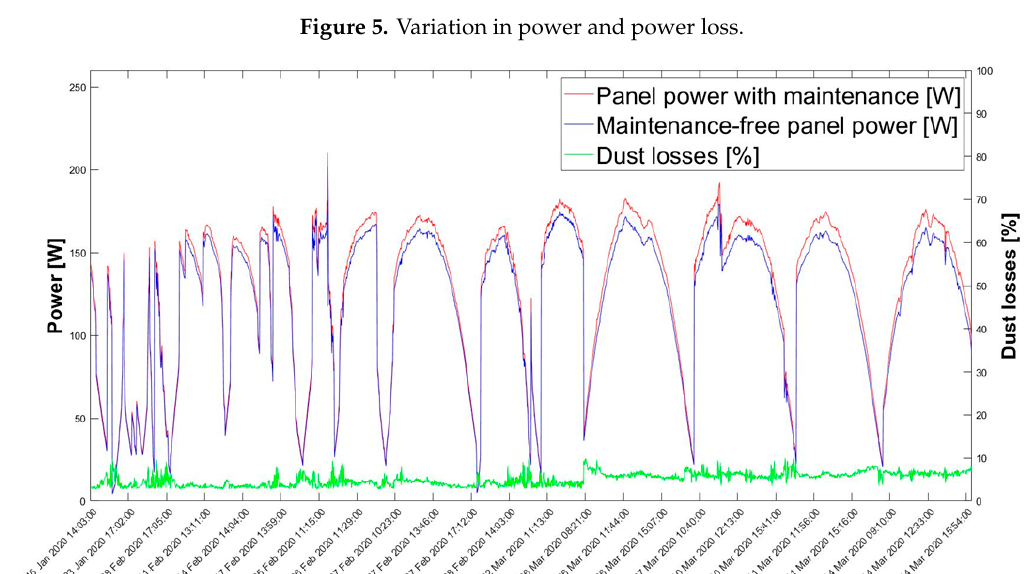
Figure 5. Variation in power and power loss.